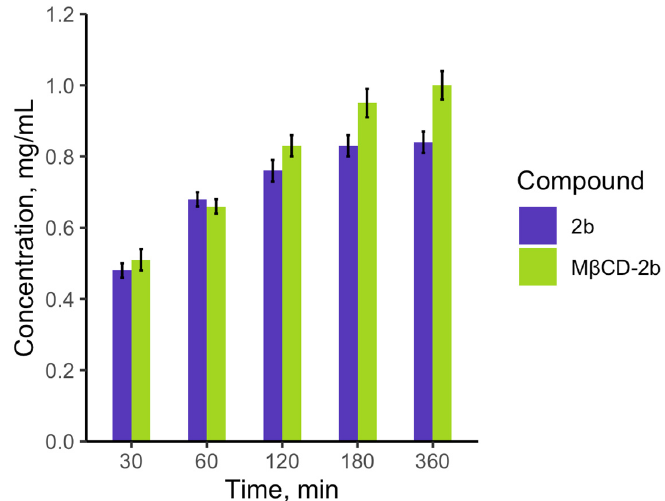
Figure 7. The dissolution rate of 2b and M β CD- 2b , sodium phosphate buffer (pH 7.4), shake-flask method.